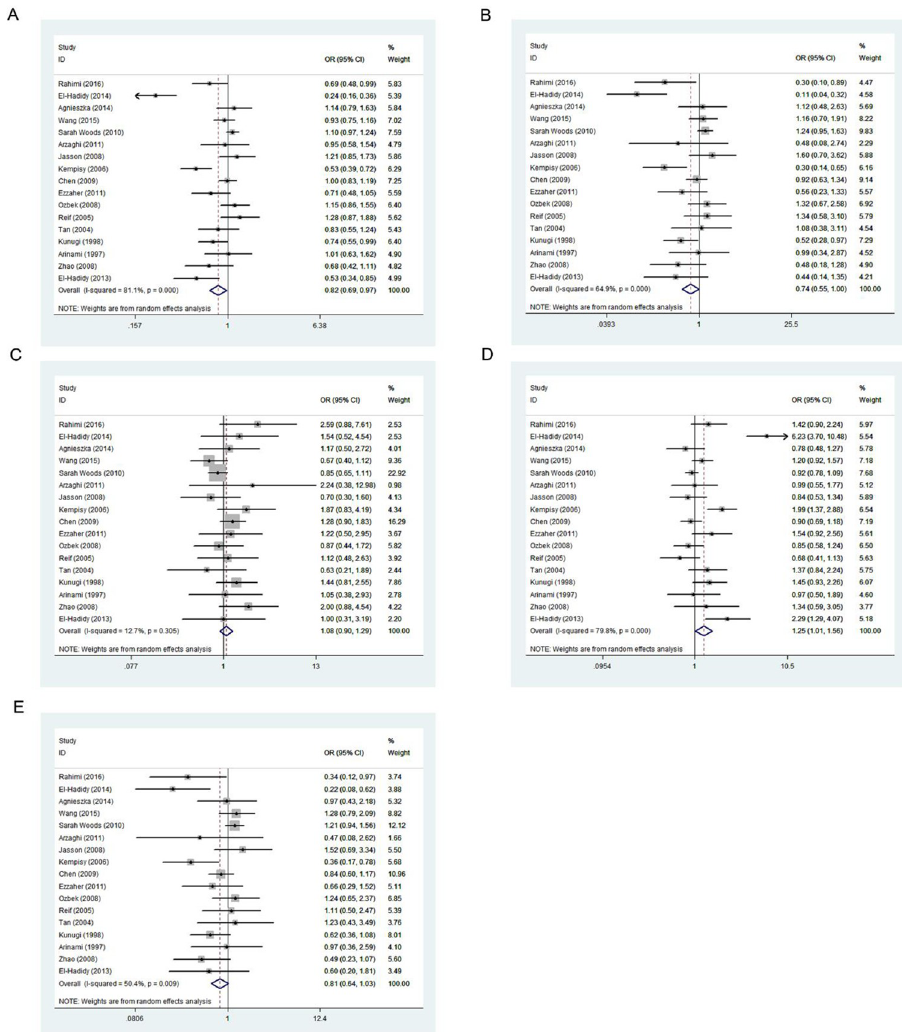
Fig 4. Forest plot of the association between 667C > T variation and risk of bipolar disorder in the five genetic models: A, allele contrast; B, homozygous codominant; C, heterozygous codominant; D, dominant; and E, recessive.